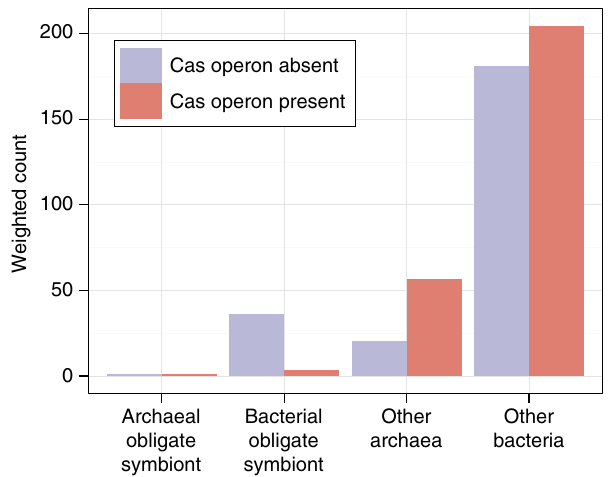
Figure 3 | Association between obligate symbiotic lifestyles and presence of CRISPR-Cas among well-studied bacteria and